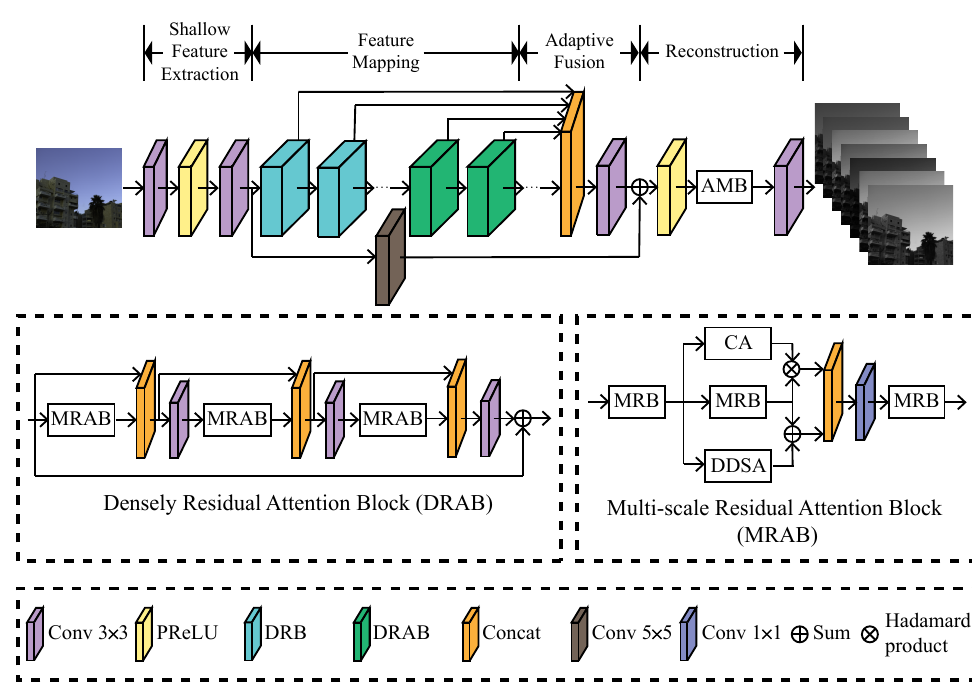
Figure 1. Network architecture of